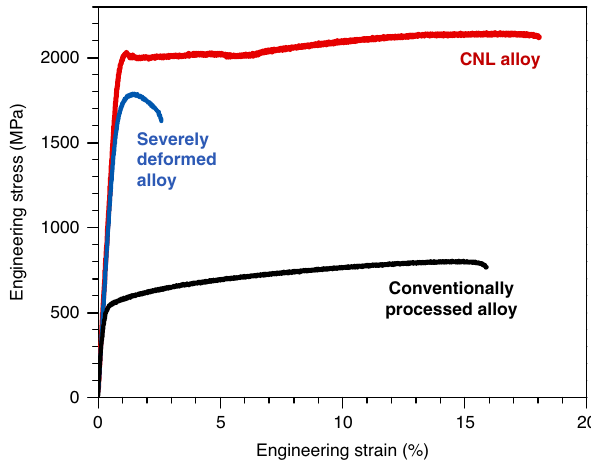
Fig. 1 Tensile stress – strain curve of the coherent nanolamellar (CNL) alloy. The curves of the conventionally processed alloy (black) and severely deformed alloy (blue), which have the same composition as the CNL alloy but without the CNL architectures, are presented for comparison. The CNL alloy (red) reveals an extraordinary combination of ultrahigh strength and large